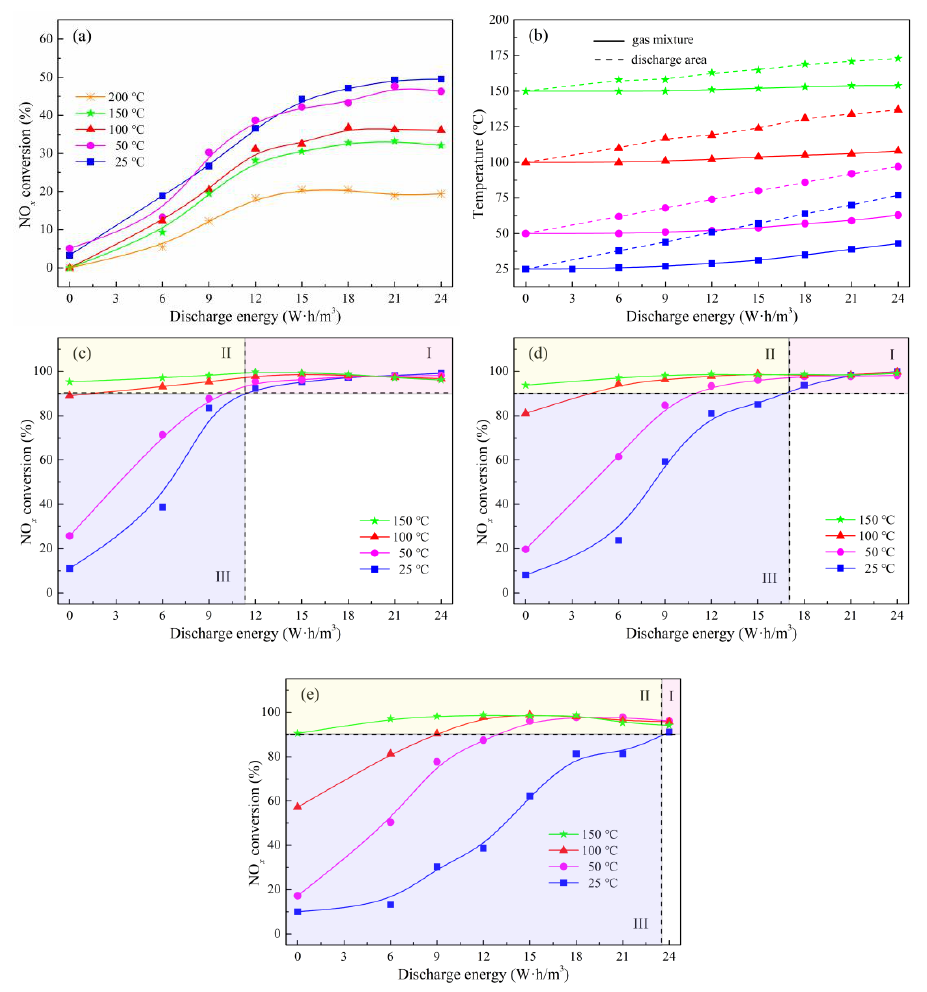
Figure 3. Effect of temperature on NO conversion. Gas mixture composition: 300 ppm NO, 300 ppm NH 3 , 8% O 2 , ~0.1% H 2 O, and N 2 as balance gas. Gas hourly space velocity (GHSV) 20,000 h − 1 . ( a ) plasma-only process; ( b ) plasma cooperate with Mn − Ce/TiO 2 nanocatalysts; ( c ) plasma cooperate with Mn−Co/TiO 2 nanocatalysts; and (d) plasma cooperate with Mn−Fe/TiO 2 nanocatalysts. Table 1. plasma-catalyst performance in previous researches. 235